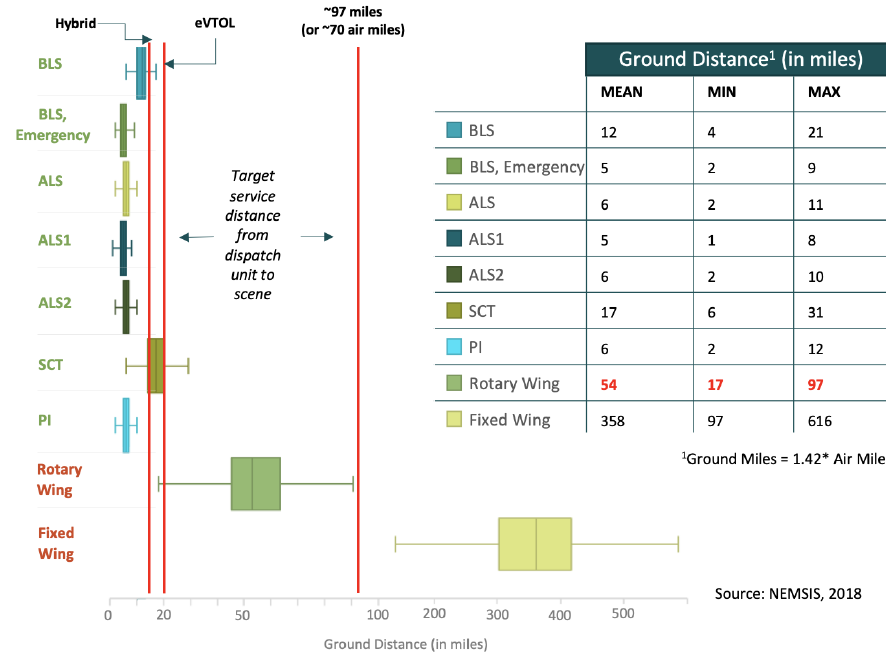
Figure 5. Typical range requirements based on CMS Service Level.